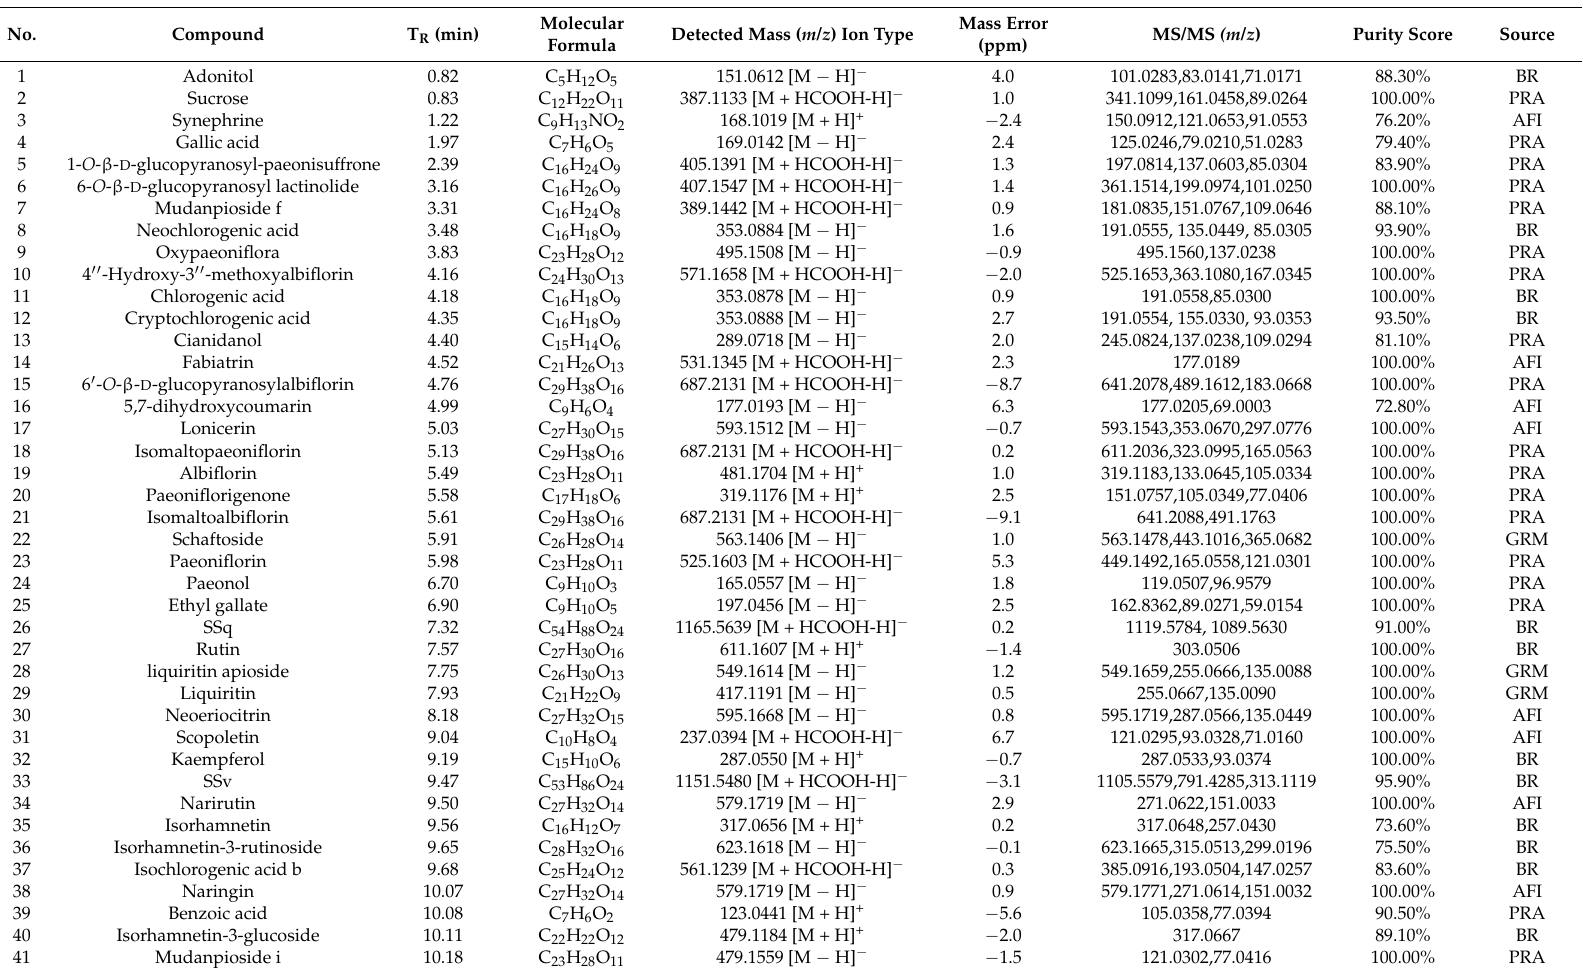
Identification of chemical compounds by ultrahigh performance liquid chromatography coupled with electrospray ionization tandem quadrupole-time-of-flight mass spectrometry